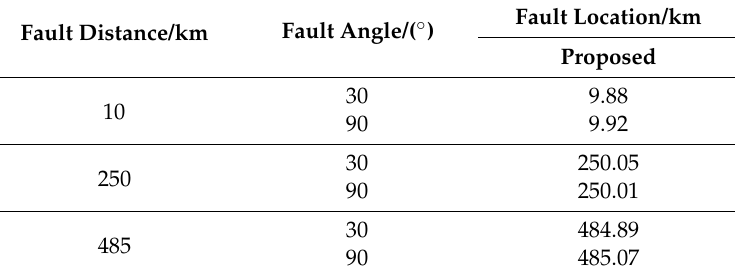
Table 5. The fault location results by 0.1 Ω fault resistance.